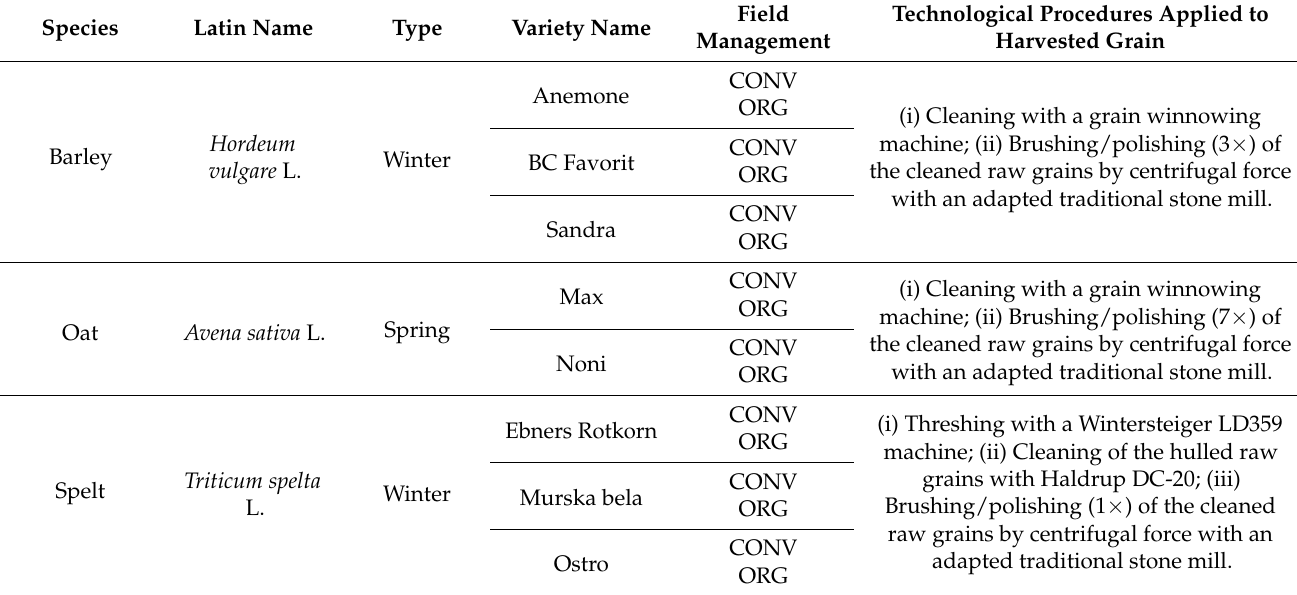
Table 1. List of studied cereal varieties grown in 2017/2018 and technological procedures applied to the harvested